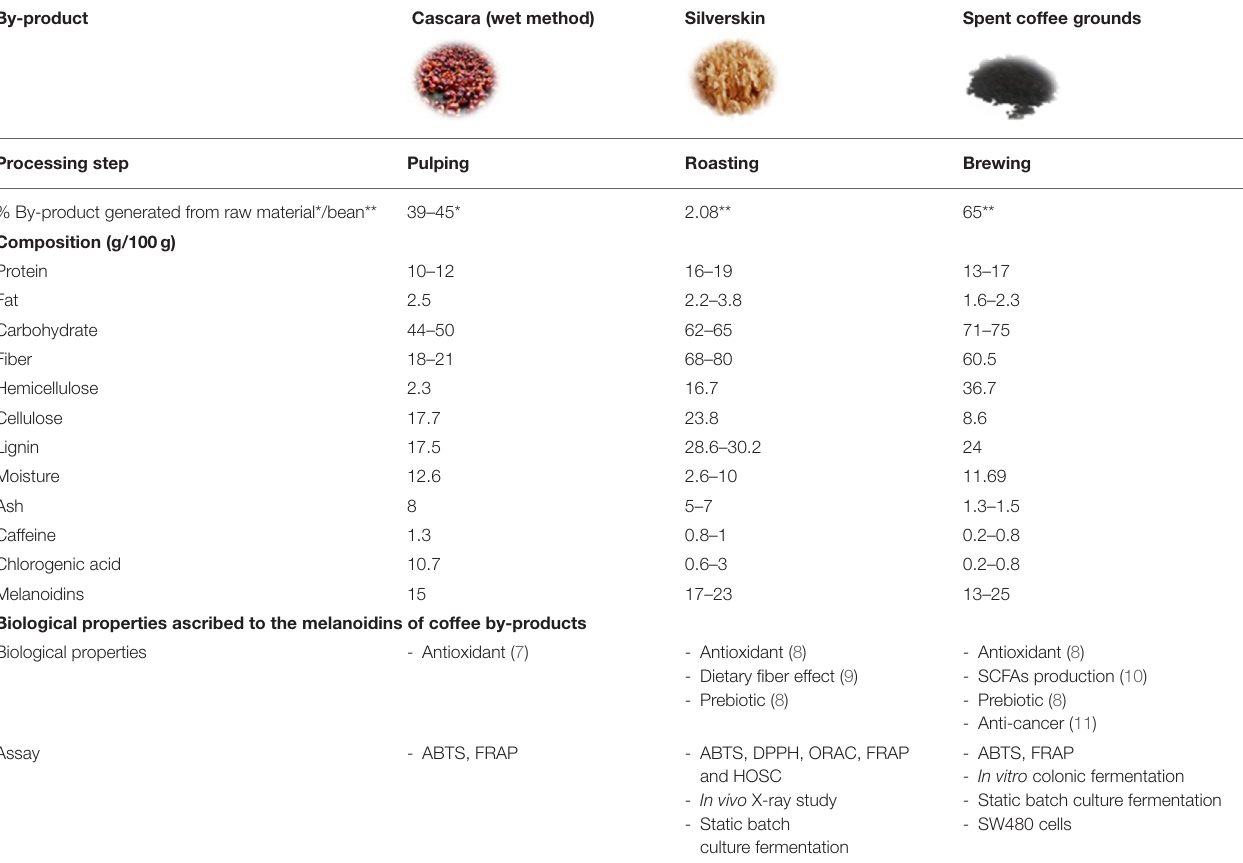
TABLE 1 | Step of generation during coffee processing, quantity, composition (5, 6), and biological properties of coffee by-products containing melanoidins. By-product Cascara (wet method)